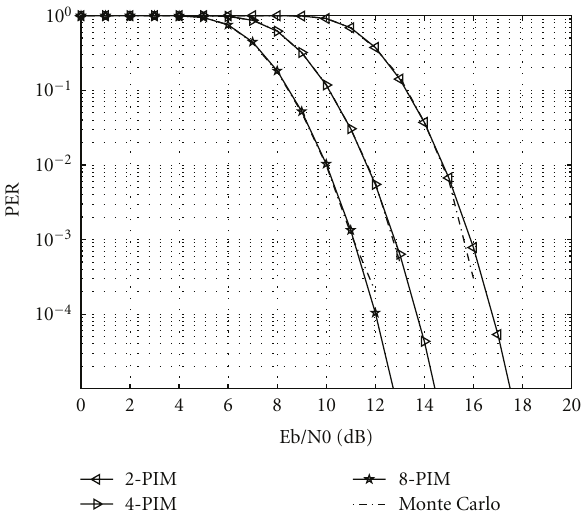
Figure 5: Comparison of PER performance between Monte Carlo simulation and the derived error probability for B = 128.